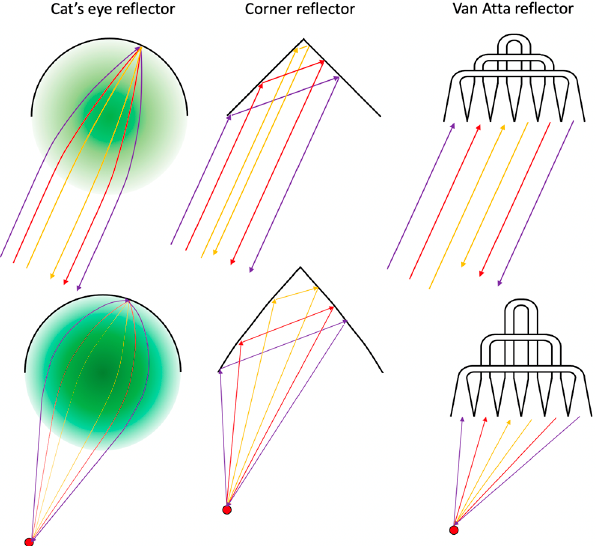
Figure 2. Sketches of some passive acoustic devices that can have reasonably broad spectral and spatial retroreflective performance. The cat’s eye reflector is a semicircular or hemispherical mirror with a lens that focuses onto it; the second-order reflection of a dihedral corner reflector, and the third-order reflection of a trihedral cube corner reflector, are retroreflected; the van Atta reflector [56] uses equal-length pipes to spatially reverse the surface. The bottom row illustrates adjustments that could lead to focusing combined with retroreflection: increasing the cat’s eye lens’ refractive index gradient, curving the corner reflector, and varying the van Atta reflector’s pipe lengths.